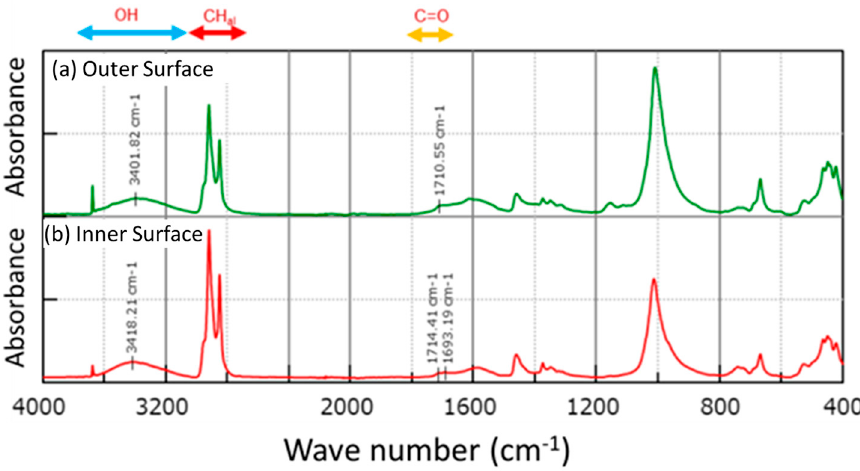
Figure 3. FT-MIR spectra observed on the outer surface ( a ) and the inner surface ( b ) of tubular specimens cut from cable B1L.